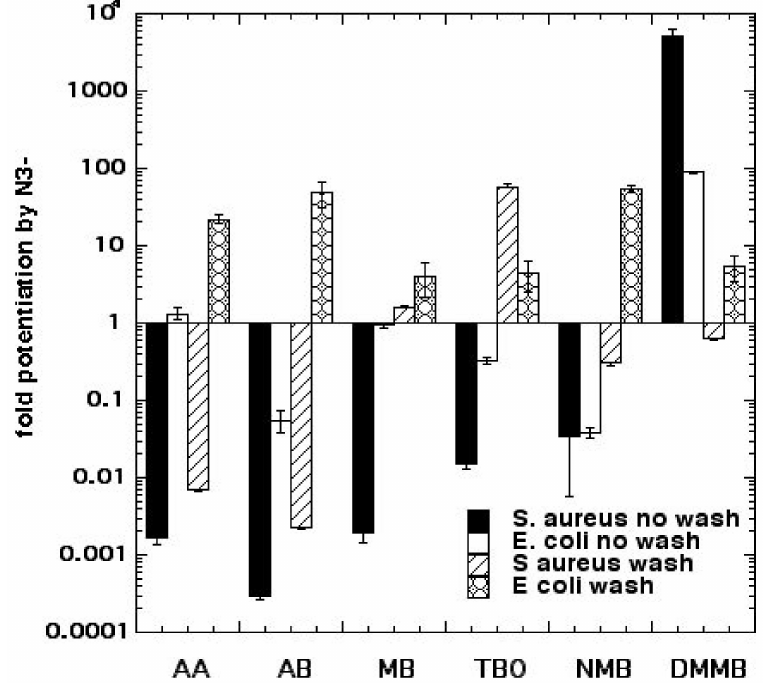
Figure 5. Comparison of six phenothizinium dyes for potentiation or inhibition of aPDI by sodium azide. Figure adapted from data contained in